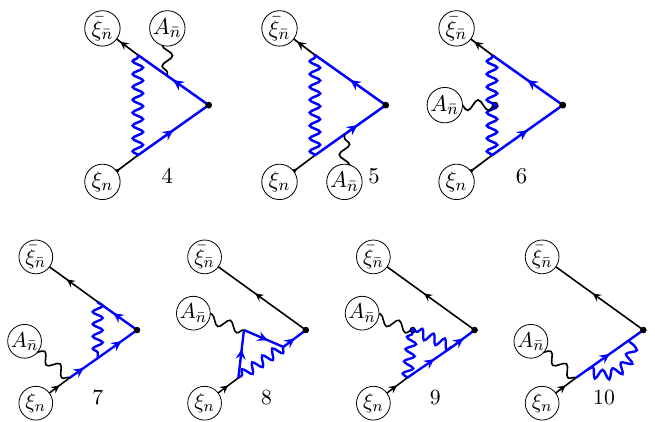
Figure 6 . The three-point diagrams contributing to the NLO of the effective operator. The diagrams with A and then with n ↔ ¯ n should be added. The blobs indicate the type of ¯ n → A n background field. The blue lines are the dynamical